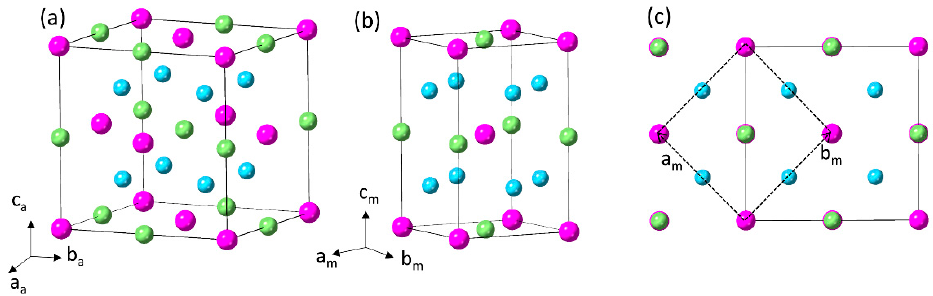
Figure 1. Fundamental crystal structures of austenitic ( a ) and martensitic ( b ) phases wherein the colored spheres define different crystallographic sites (light green = Ga, cyan = Ni, pink = Mn). ( c ) Reciprocal relation between the two lattices. The a and m subscripts of the crystallographic axes stand for austenite and martensite respectively.